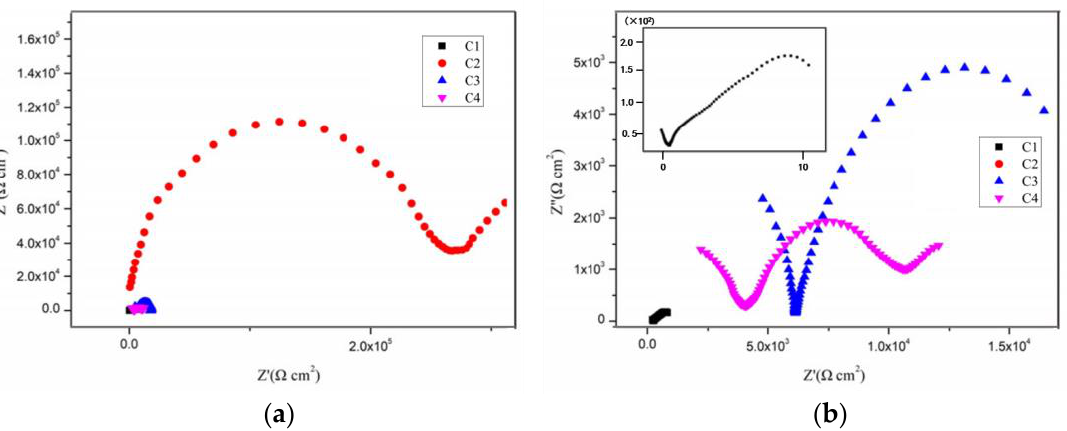
Figure 5. Nyquist plots of coatings after immersion for 11 d: ( a ) Nyquist patterns for 11 d and ( b ) enlarged view of the high frequency of Nyquist patterns.